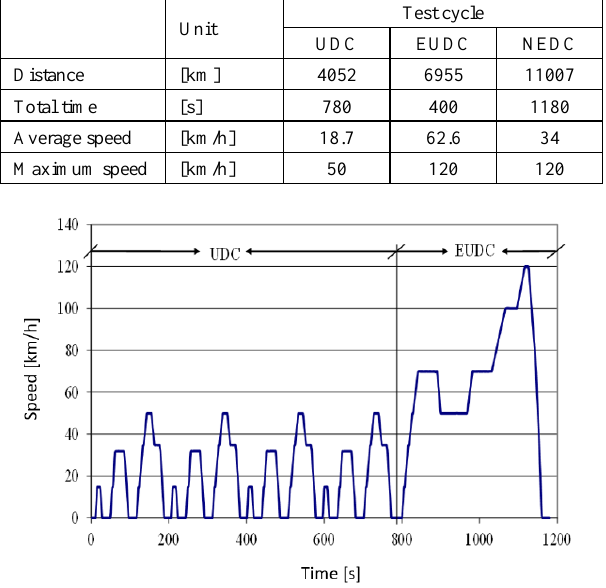
Fig. 1. The vehicle speed during NEDC test cycle